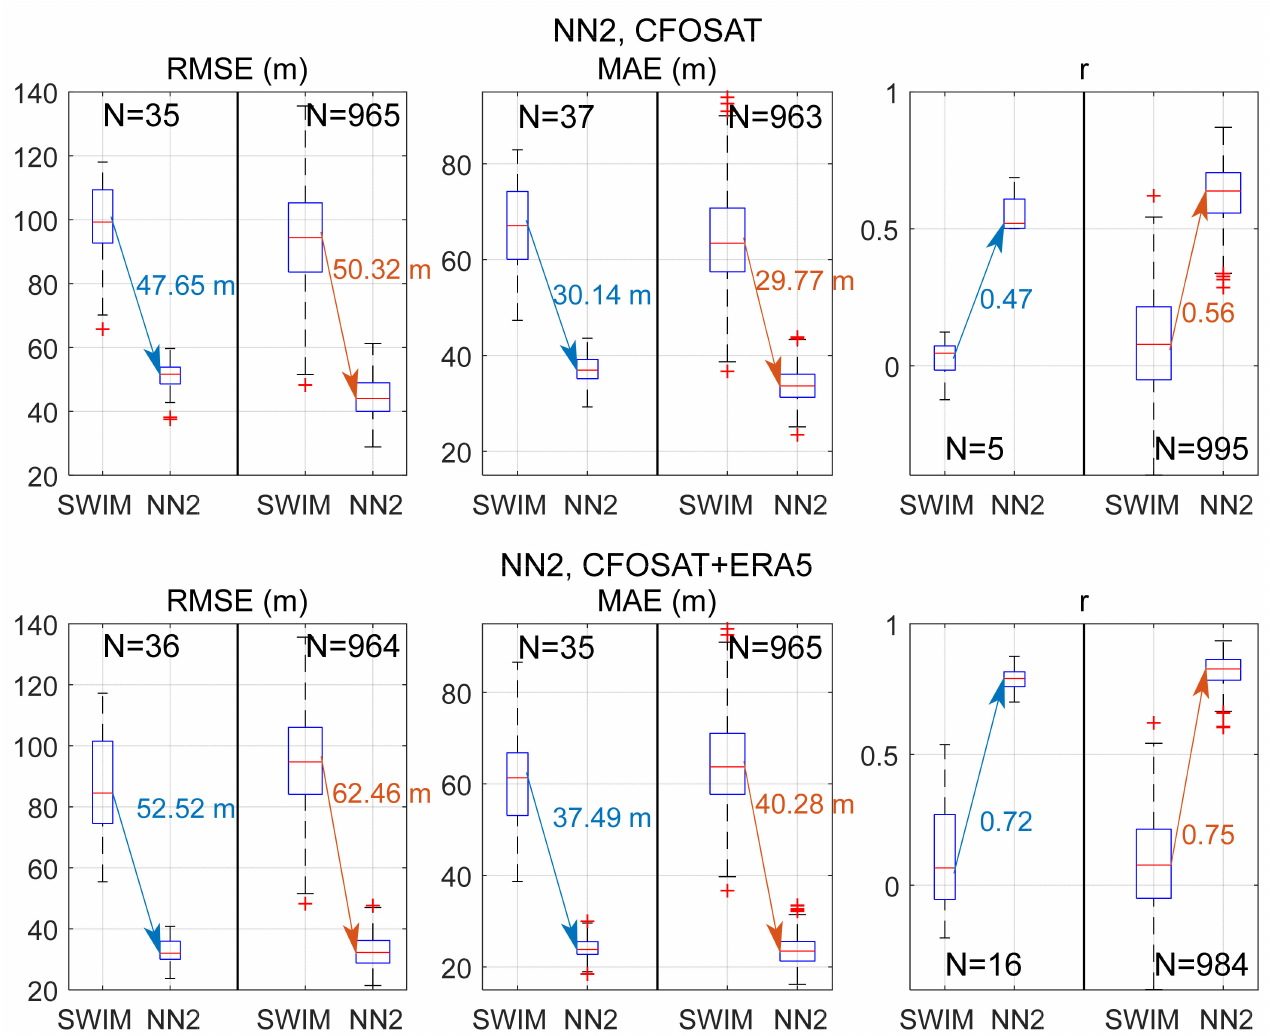
Figure 14. Boxplot comparison of validation results between the abnormal (left in each subplot) and normal (right in each subplot) NN2 models at buoy A. The abnormal and normal models are corresponding to the outlier samples (in red “+”) and remaining samples in Figure 13, respectively. The upper panels show the self-calibration results with CFOSAT parameters, and the lower panels show external-source calibration in which both CFOSAT and ERA5 parameters are